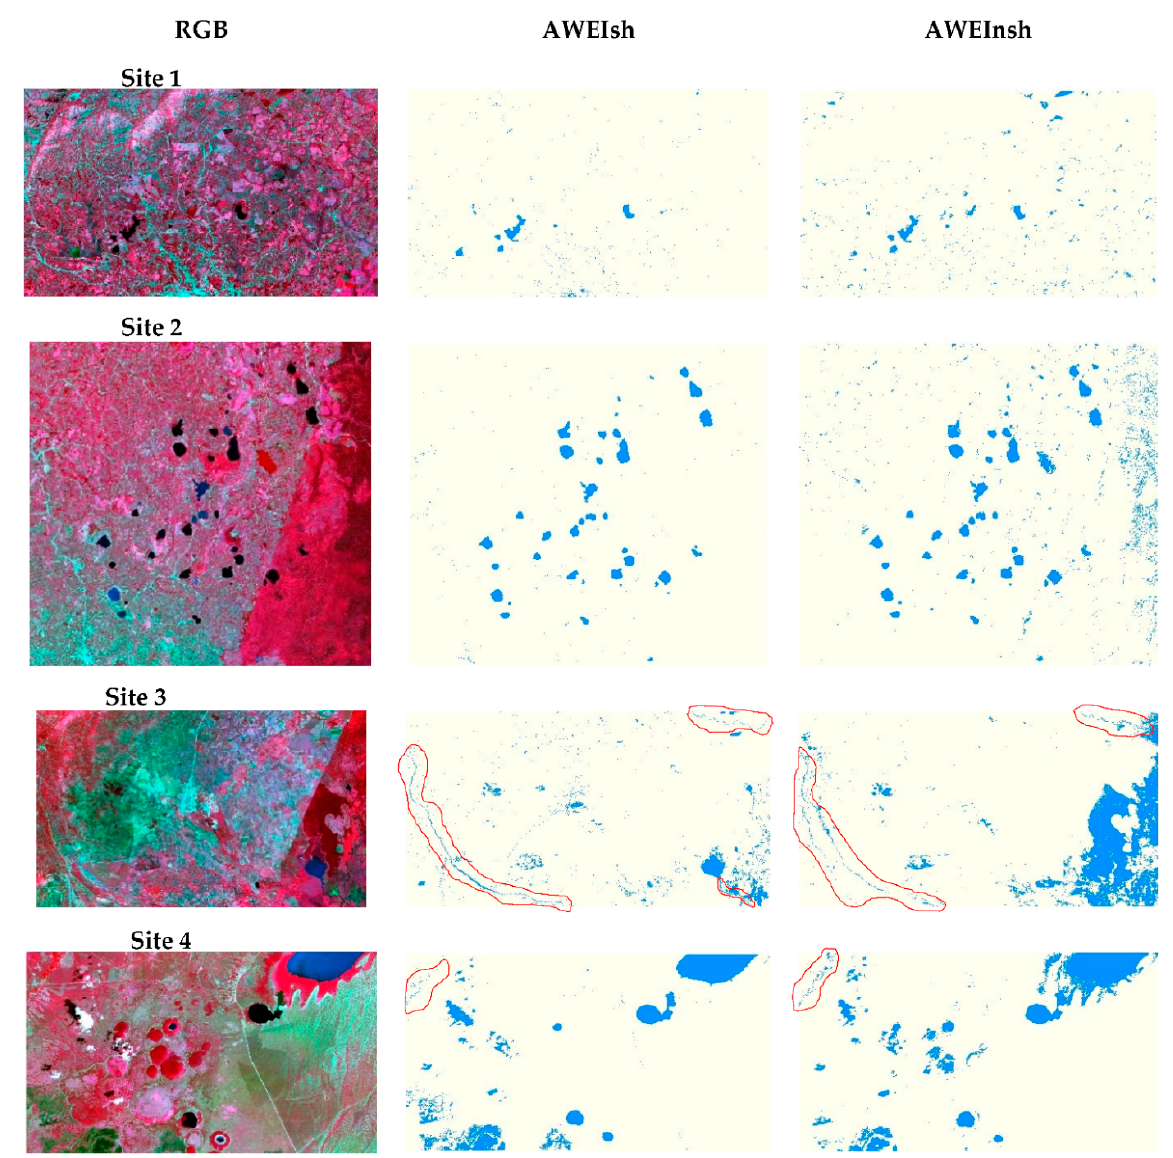
Figure 6. Water maps as classified by AWEI for the various sites (Blue is water while white is non-water). The red highlights show rivers or streams. Comparisons follow rows where the Sentinel-2 MSI RGB (8,4,3) false-color composite image of a particular site is on the ( left ), followed by the AWEIsh binary classified image ( middle ), and then the AWEInsh binary classified image ( right ). Further illustrations of water maps are in Figures S1–S4.